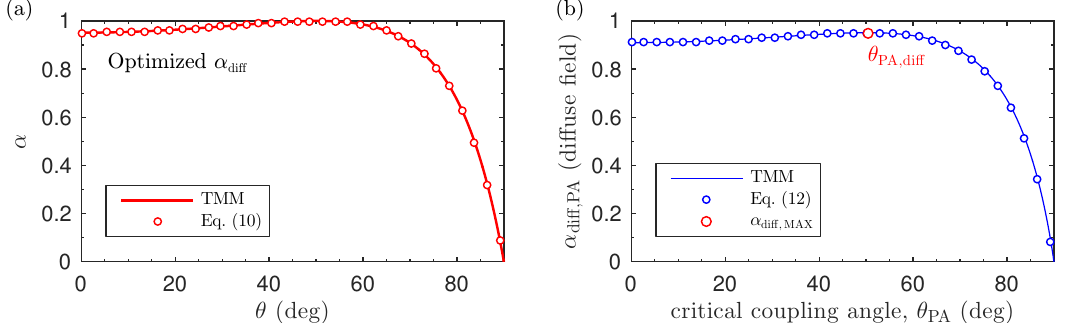
Figure 6. ( a ) Angle-dependent absorption of the optimal diffuse-field absorber using TMM (continuous line) and Equation (10), at f 0 = 300 Hz; ( b ) Absorption in diffuse field as a function of the critical coupling angle. The maximum absorption in diffuse field is α diff,MAX = 0.952, and is achieved for a structure critically-coupled at θ PA,diff = 50.34 ◦